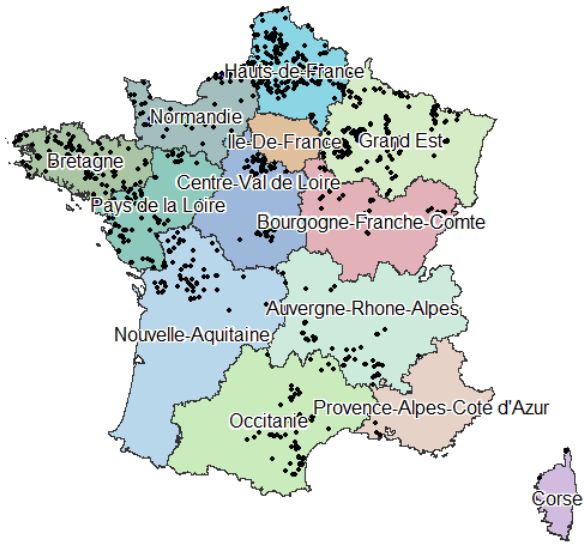
Figure 2. Localisation of metropolitan French wind farms (2017, www.thewindpower.net, accessed on 1 December 2021).